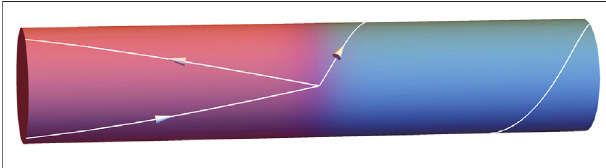
FIGURE 5 | Magnon scattering due to the Skyrmion-textured domain wall. The red and blue regions represent the domains whose background magnetizations are m 0 (cid:1) − ^ z and m 0 (cid:1) ^ z , respectively. The spin wave coming from z = − ∞ with non-zero l scatters with the Skyrmion-textured domain wall. Finite amount of the incoming spin wave is re fl ected.